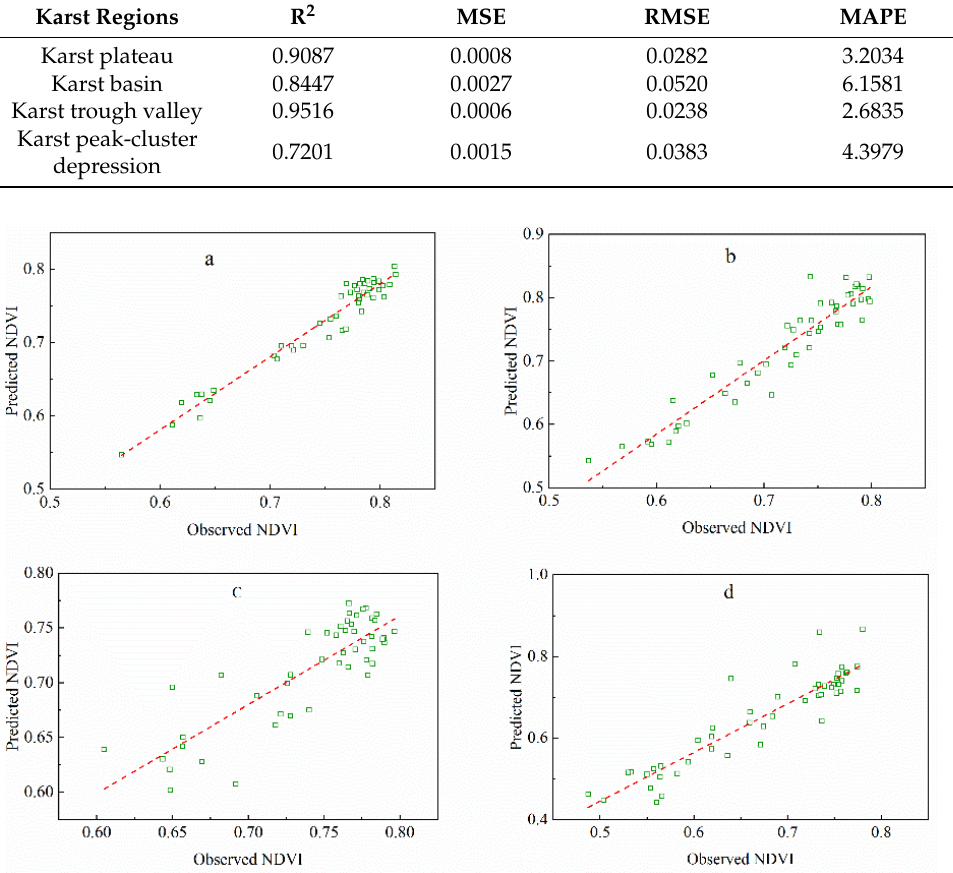
Figure 4. Comparison of the observed and RBFNN predicted NDVI in the ( a ) karst trough valley, ( b ) karst plateau, ( c ) karst peak-cluster depression, and ( d ) karst basin.